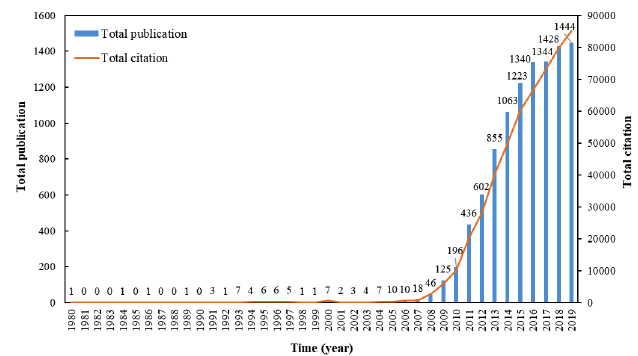
Figure 2. The annual trend in quantity of publications and citations from 1980 to